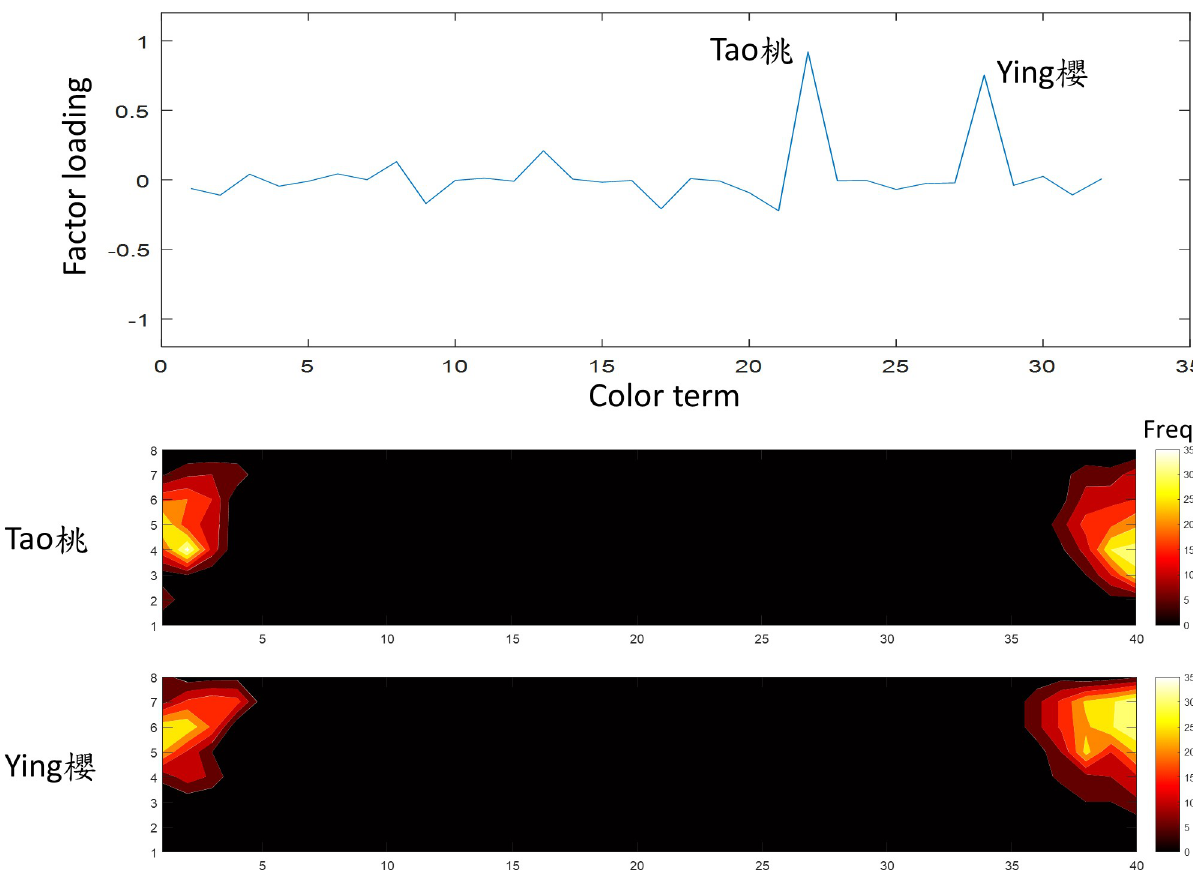
Fig 12. The eighth factor was “pink”. The terms Ying and Tao ( 櫻 , 桃 ) showed a high loading on this factor. The convention of the figure is the same as Fig 5.